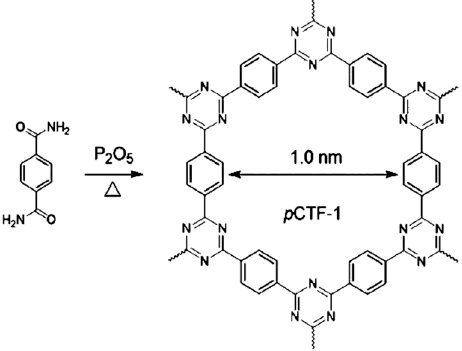
Figure 6. Dehydration polymerization of CTF-1 from the monomer terephthalamide over P 2 O 5